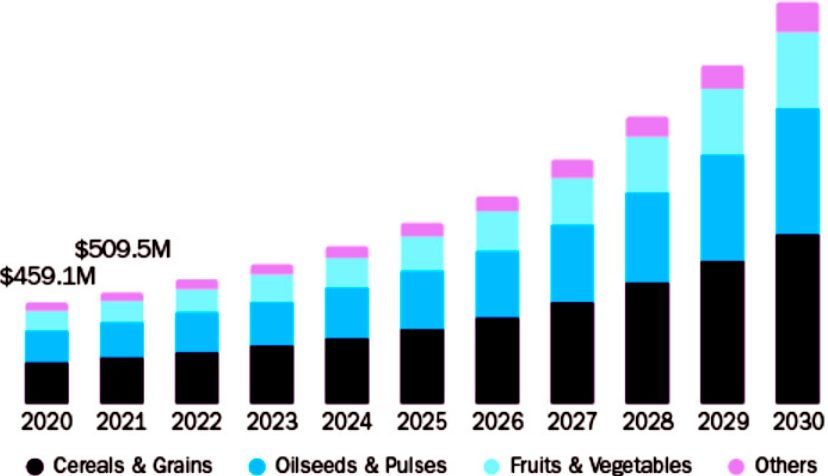
Figure 1. A prediction of the global market for major crops using nanofertilizers for the years 2022– 2030. (Source: https://www.grandviewresearch.com/industry-analysis/nano-fertilizer-market-report accessed on 12 December 2022)